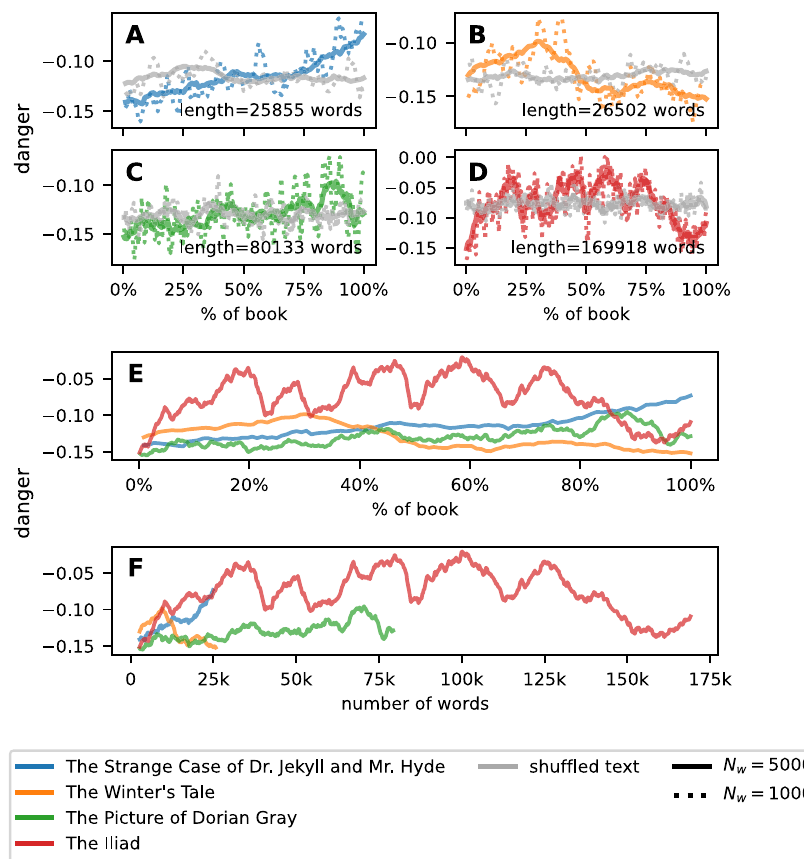
Fig. 2 Time series for books of different lengths in raw and normalized word-time. A – D These plots illustrate the effect of window sizes, shuf fl ing, and book length on how danger scores change over the course of a book. Using larger window sizes (solid vs. dotted) results in smoother curves, although longer books tend to retain fl uctuations in the time series for the same window size ( A , B vs. C , D ). Shuf fl ing the text results in time series that are fl atter than the original (gray). E Comparing books using normalized word-time shows more fl uctuations for longer books than shorter ones, but F plotting the time series in raw word-time shows similarities between shorter books and sections of longer books. A skip size of N s = 200 words was used for all plots shown Fig. 4. The variance of the IMFs in the shuf fl ed texts generally decreases as the IMF order increases, similar to the observation for fractional Gaussian noise (Flandrin et al., 2004; Wu and Huang, 2004). However, this is not always true for the original texts. For example, “ The Iliad ” shows a clear example of a book that differs in variance from the shuf fl ed text from an IMF order below the trend, and continues to do so until the trend level. On the other hand, “ The Picture of Dorian Gray ” clearly differs in the variance at an IMF order below the trend, but does not always do so for higher IMF orders. In some books, such as “ The Strange Case of Dr. Jekyll and Mr. Hyde ” , the original and shuf fl ed ver- sions only differ in the variance at the trend level.